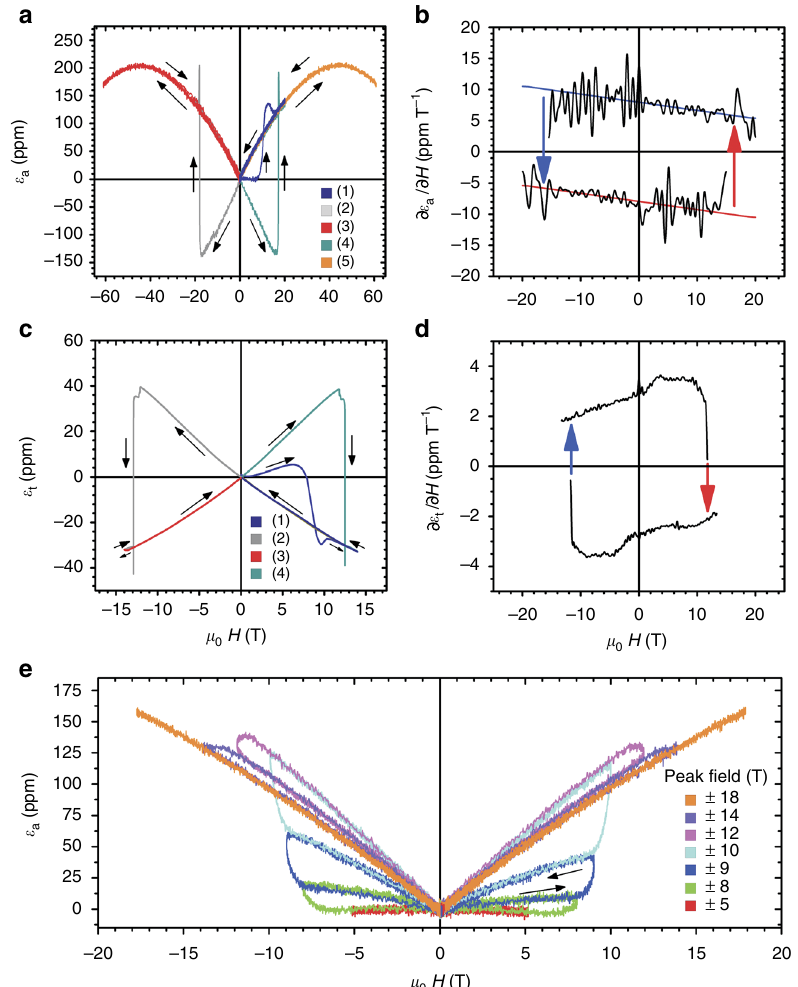
Fig. 2 Domain dynamics and magnetoelastic memory in UO 2 . a Axial magnetostriction ε a vs. H parallel to [111] in the AFM state of UO 2 in pulsed magnetic fi elds ( T = 2.5 K). The measurement sequence is explained in the text. b Magnetostriction slope ∂ ε ∂ H vs. magnetic fi eld parallel to [111], along a strain a / hysteresis loop showing remanence. Lines are fi ts that reveal y -axis intersections α a = ± 10.5 ppm T − 1 and slope 2 β a = 0.17 ppm T − 2 . c Transverse magnetostriction ε t vs. H parallel to [111] measured at T = 2.2 K in a superconducting magnet using a sequence like the one used in a . Here we observe qualitatively similar, yet opposite in sign, behavior as in ε a (H). d ∂ ε t / ∂ H corresponding to the hysteresis loop in c showing remanence. The fi tted y - axis intersections are α t = ± 2.98 ppm T − 1 , and slope 2 β t = 0.09 ppm T − 2 . e A partial domain reorientation effect, magnetoelastic butter fl y, is obtained when magnetic fi elds are pulsed consecutively to fi elds between 5 T ( red ) and 14 T ( purple ). An equilibrium state is achieved with a 18 T pulse ( orange ). As seen, the domain reorientation effect can be partial, allowing for tuning of ∂ ε / ∂ H . These characteristics make the gradual reorientation of magnetic domains